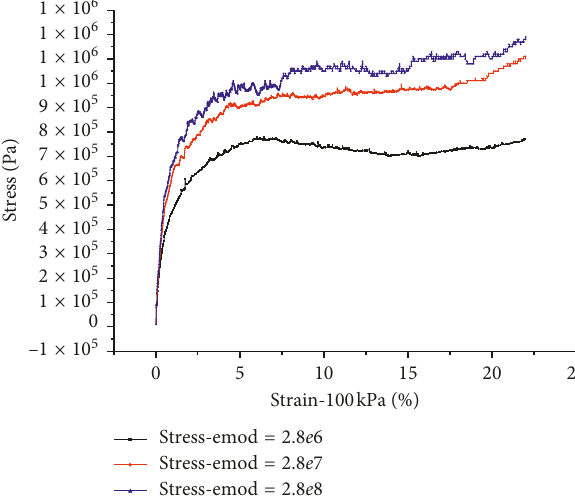
Figure 4: Stress-strain of different frictions under 100kPa. stratum formed by the combination of the underlying mudstone is not considered for the time being. Simplify the model and replace the miscellaneous fill, silty clay, and middle